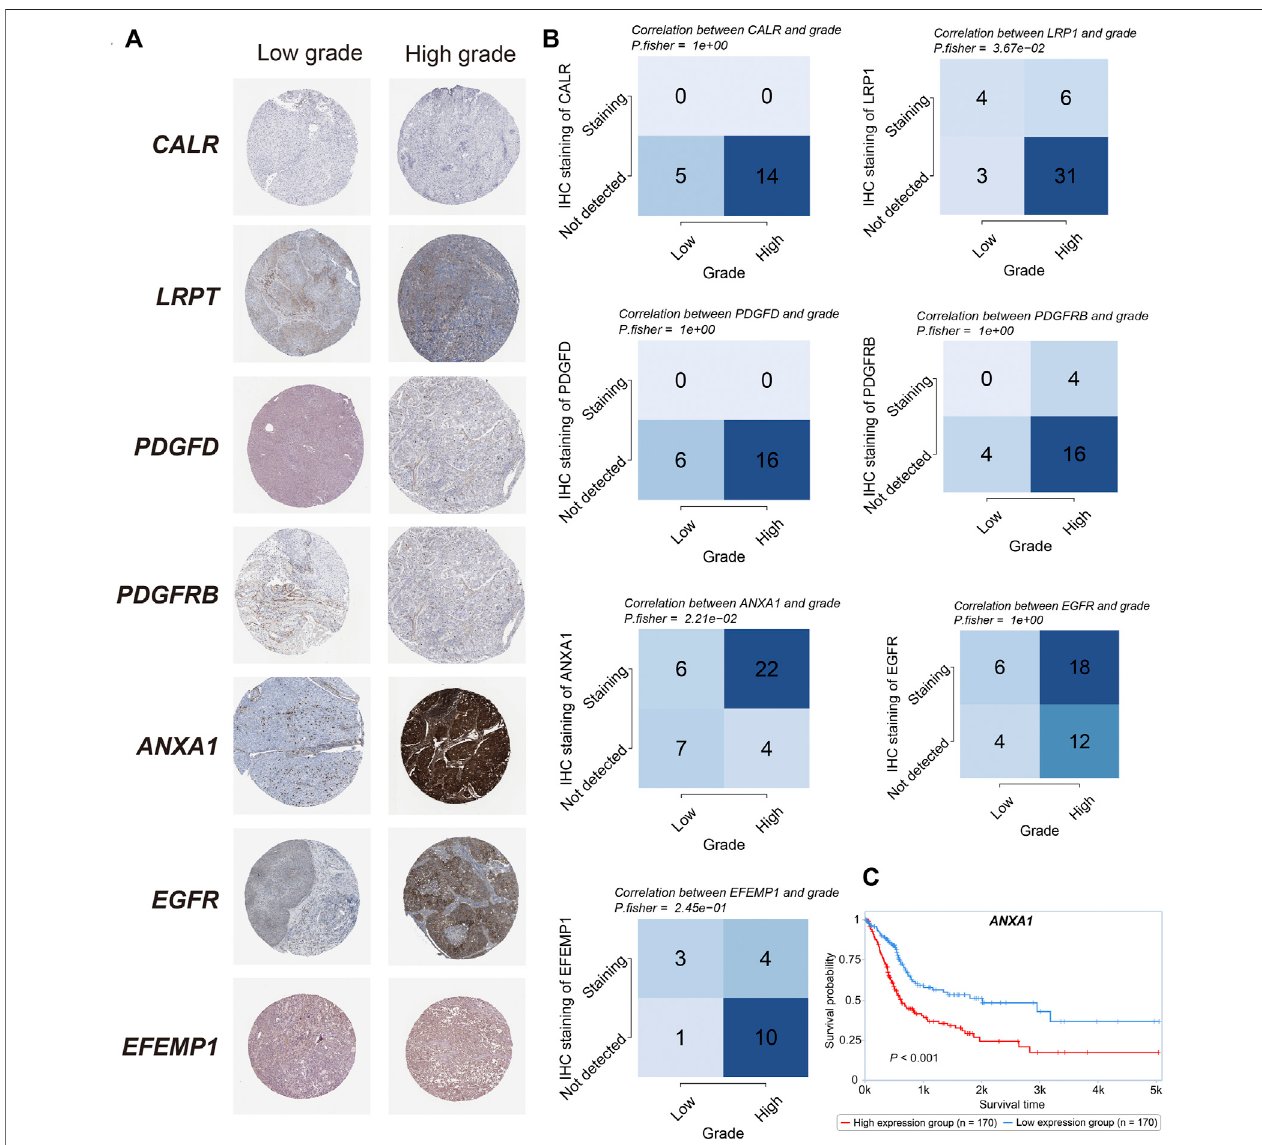
FIGURE 9 | Protein validations (A) . IHC staining of CALR, LRP1, PDGFD, PDGFRB, ANXA1, EGFR, and EFEMP1 between high- and low-grade bladder cancer. (B) .Thecorrelationbetween thegradeand survivalstatus and IHCstainingin CALR,LRP1,PDGFD,PDGFRB, ANXA1, EGFR,and EFEMP1(Fisher ’ sexact test). (C) . Kaplan – Meier curve of the overall survival between high- and low- ANXA1 expression in the protein level ( p < 0.001).